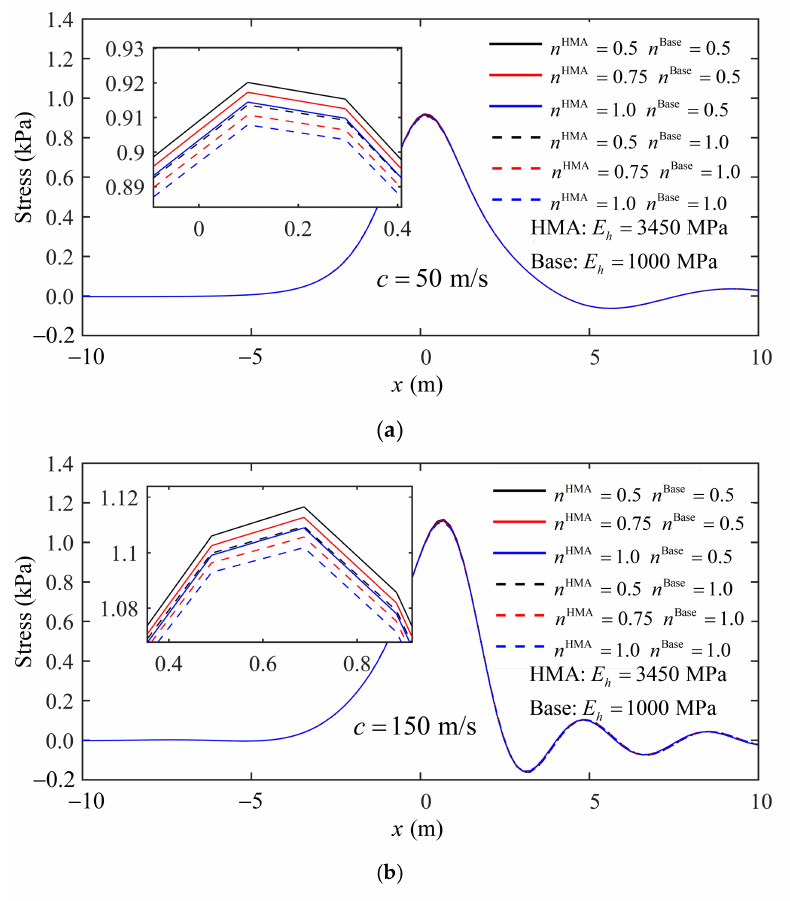
Figure 18. Effect of the layer modulus ratio, n = E h / E v , with a fixed horizontal modulus on the vertical stress fluctuation amplitude at the lower bound of the base layer, induced by a moving Gaussian load, with speeds ( a ) c = 50 m/s and ( b ) c = 150